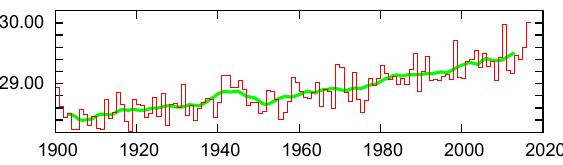
Figure 3. March–May mean sea surface temperature in the north- ern Indian Ocean (EQ 30 ◦ N, 60–100 ◦ E) ( ◦ C). Source: ERSST v4 (Huang et al.,